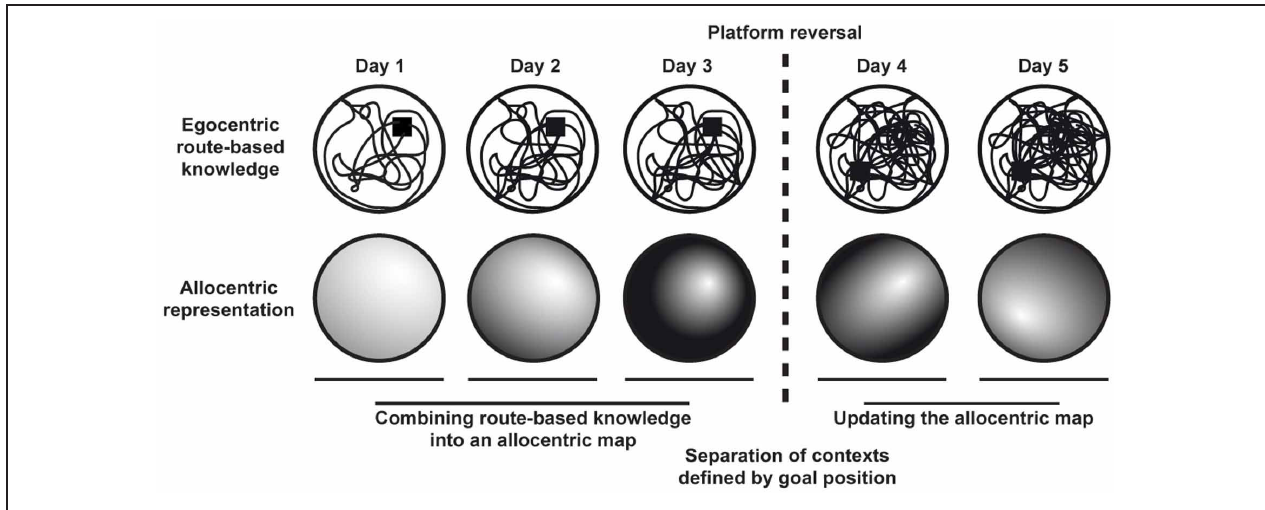
FIGURE 3 | Formation and updating of allocentric cognitive maps in a task with changing goal positions. Egocentric route-based knowledge from repeated trials becomes integrated into an allocentric cognitive map.